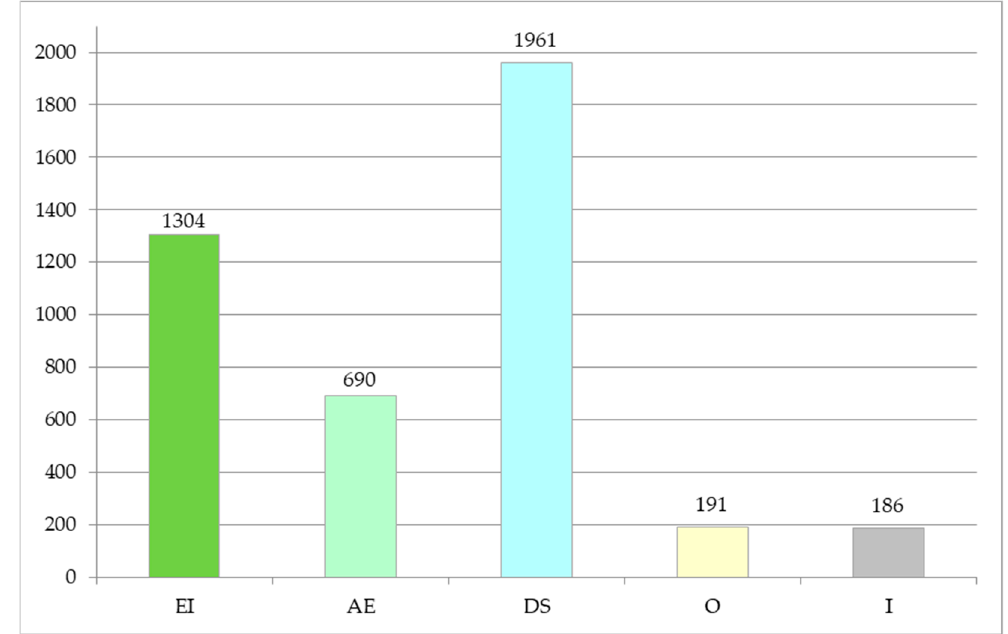
Figure 1. Distribution of respondents assigned to particular behavioural segments.